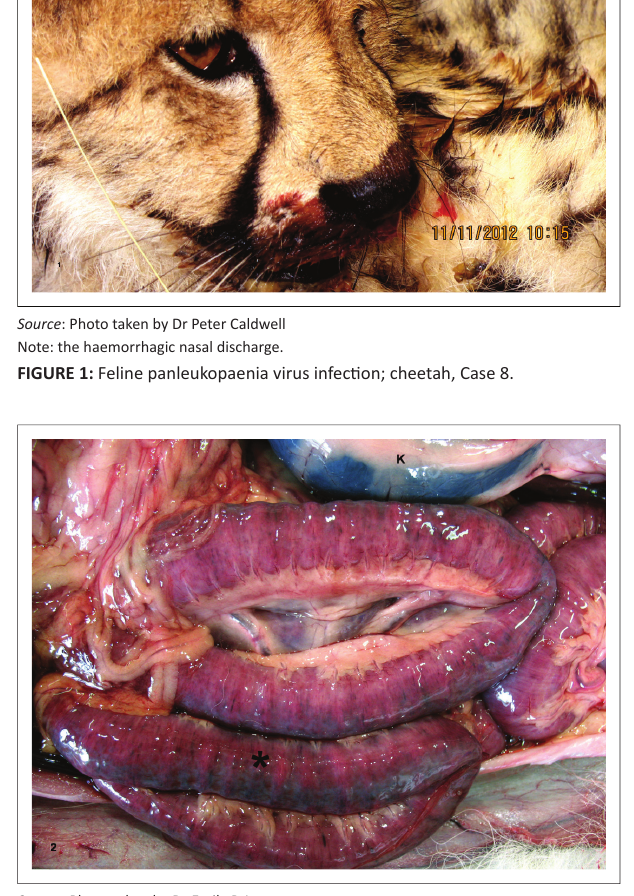
Source : Photo taken by Dr Emily P. Lane FIGURE 2: Feline panleukopaenia virus infection; abdomen, cheetah, Case 9. Severe intestinal serosal congestion and petechiation ( * ) of the intestinal loops adjacent to the kidney (K).